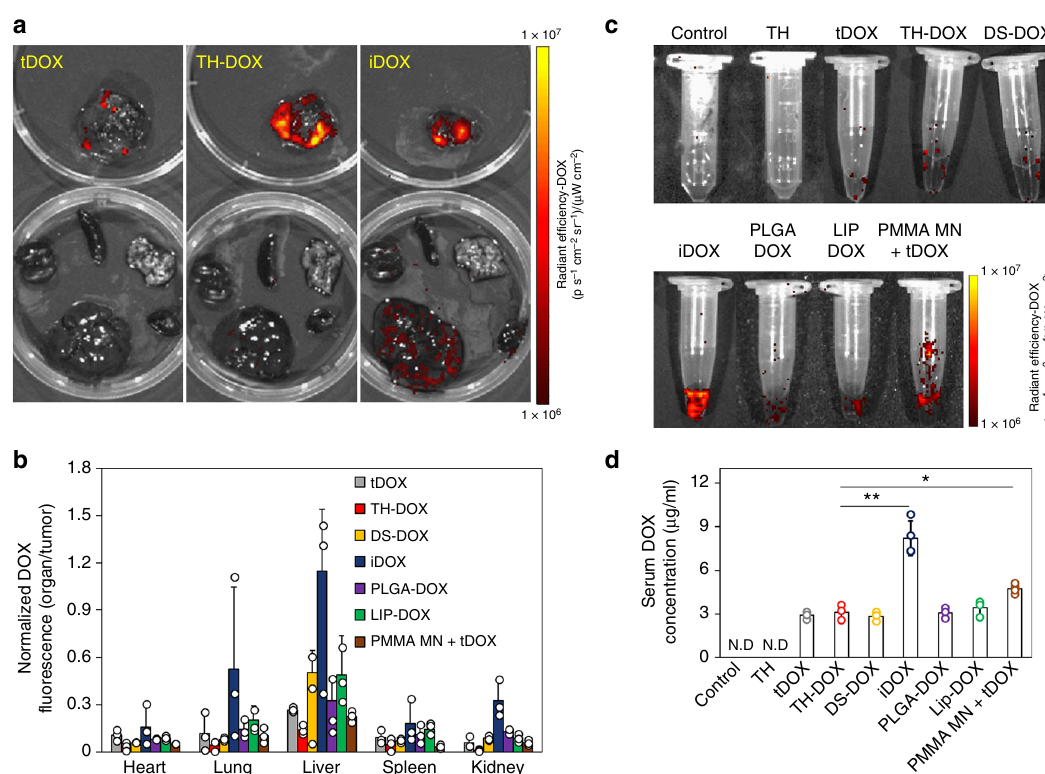
Fig. 7 Biodistribution of DOX following treatment with different DOX formulations: a Representative image for tDOX, TH-DOX, and iDOX treatment group and b quanti fi ed DOX fl uorescence from IVIS imaging of isolated tumors (top) and organs (bottom; heart, spleen, lung, liver, and kidney). c Representative IVIS image showing DOX fl uorescence from serums of treated mice. d Serum DOX quanti fi cation through fl uorescence fi tting against standard curve. Each dot on bar charts represent an independent sample measurement. Source data are provided as a Source Data fi le. Error bars represent standard deviation. N.D: non-determinable value, * p < 0.05, ** p < 0.01 (one-way